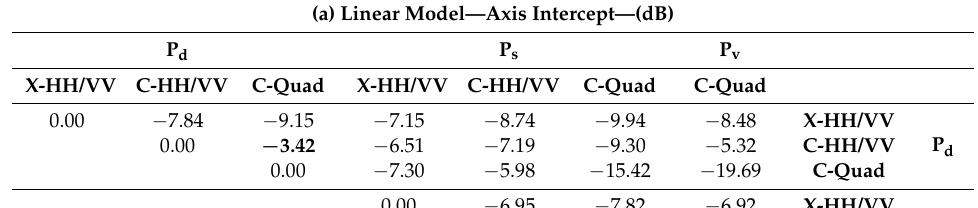
Table 6. Average linear model parameters: axis intercept ( a ), slope ( b ) and Root Mean Square Error ( c ) of C-Band Radarsat-2 and X-Band TerraSAR-X data for two and three component decomposition features double bounce (P d ), surface scattering (P s ) and volume scattering (P v